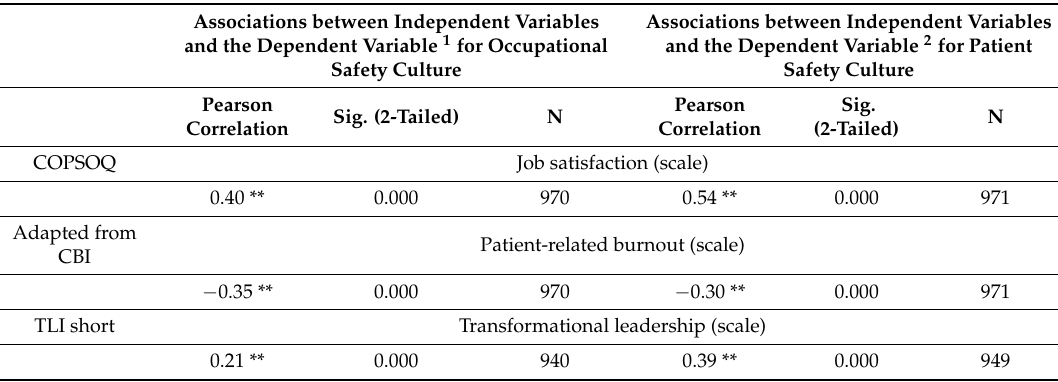
Table 8. Correlations of independent variables used in both